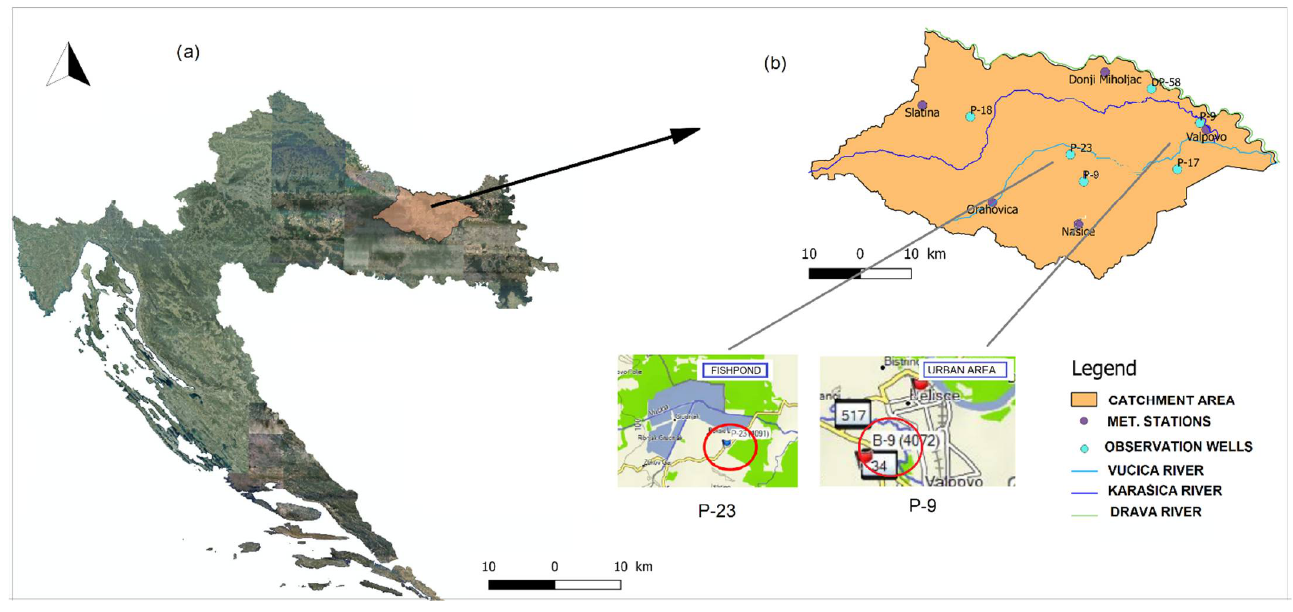
Figure 1. ( a ) Remote sensing map of study area, https://geoportal.dgu.hr (accessed on 20 March 2022), ( b ) catchment area with designated main watercourses and observation wells particularly P-29 and P-9.